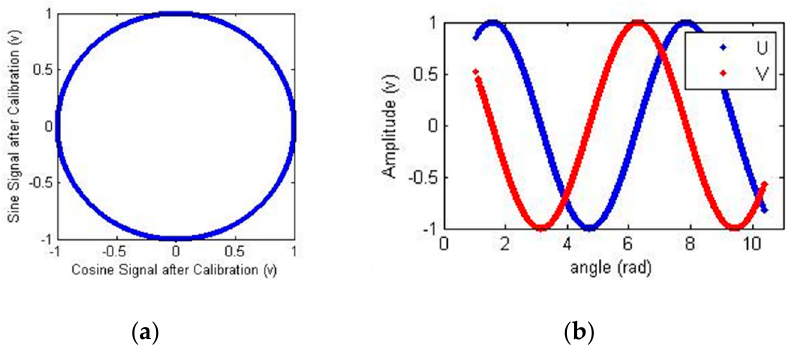
Figure 11. Calibrated signals. ( a ) Calibrated Lissajous figure; ( b ) calibrated sine and cosine signals.